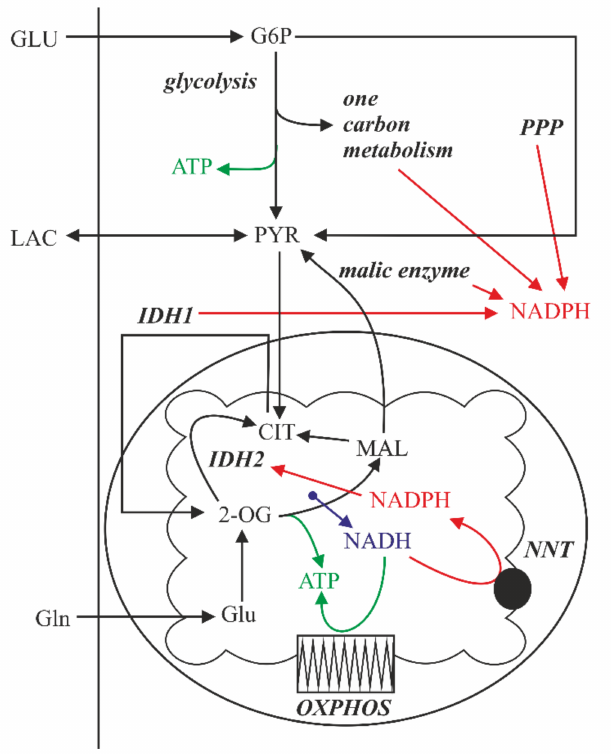
Figure 6. Partitioning of metabolic flow between the production of ATP and NADPH. ATP— adenosine triphosphate, CIT—citrate, GLU—glucose, G6P—glucose-6-phosphate, Gln—glutamine, Glu—glutamate, IDH1(2)—isocitrate dehydrogenase 1(2), LAC—lactate, MAL—malate, NAD(P)H— nicotinamide adenine dinucleotide (phosphate), NNT—nicotinamide nucleotide transhydrogenase, 2-OG—2-oxoglutarate, OXPHOS—mitochondrial oxidative phosphorylation system, PPP—pentose phosphate pathway,